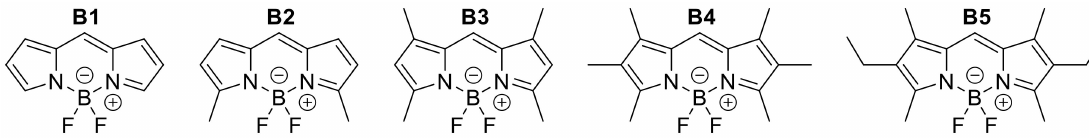
Figure A1. Hydrogen atoms placed at the meso position.